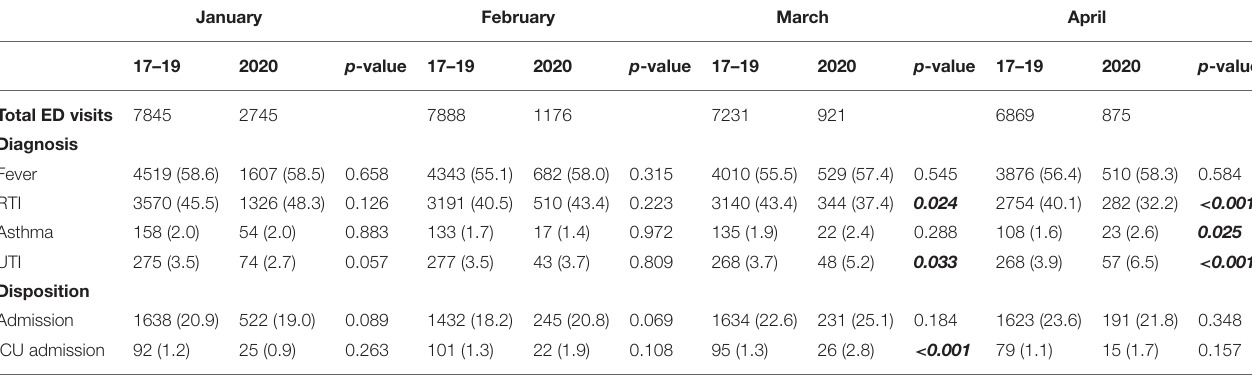
TABLE 2 | Number of ED visits and ratio (%) regarding diagnosis and patient disposition at Kaohsiung Chang Gung Memorial